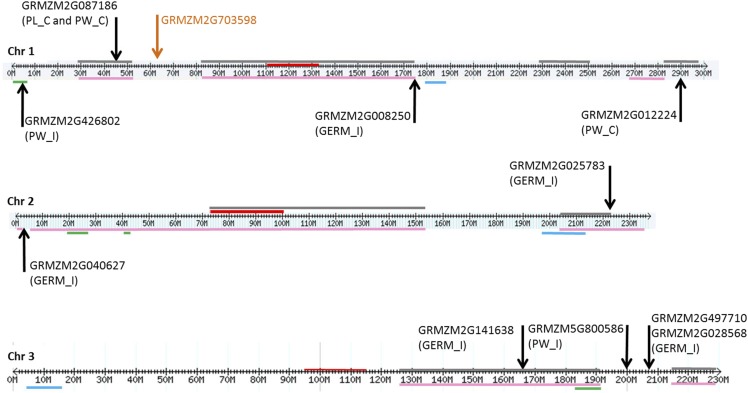
Localization of QTL and genes containing or adjacent to SNPs identified by GWAS on chromosomes 1, 2 and 3. Genes associated with different traits (PL_C; PL_I; PW_C; PW_I; GERM_C; GERM_I) from this study are indicated by the black arrow. Candidate genes from Zila et al. (2013) are indicated by the orange arrow. Horizontal lines of different colors represent different QTL intervals for resistance to Fusarium and fumonisin accumulation identified by previous reports: pink and gray (Fusarium ear rot and fumonisins from Lanubile et al. 2014b and Maschietto et al. 2017, respectively); green (Fusarium seed rot from Ju et al. 2017); blue (Fusarium seedling rot, plant length and weight from Septiani et al. 2019). The centromere is indicated by a red label on the chromosome.